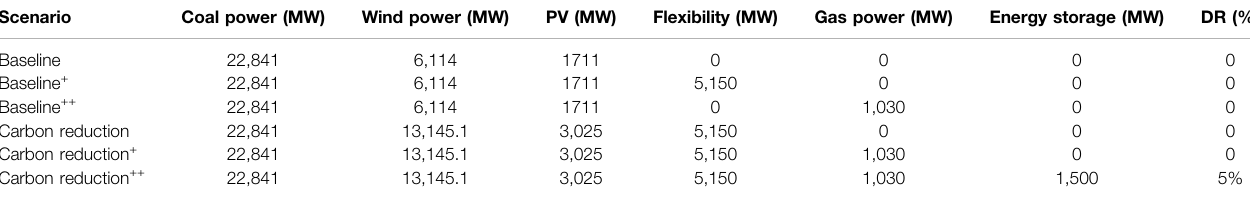
TABLE 1 | Scenario settings for evaluation of power system fl exibility in the Heilongjiang power grid .